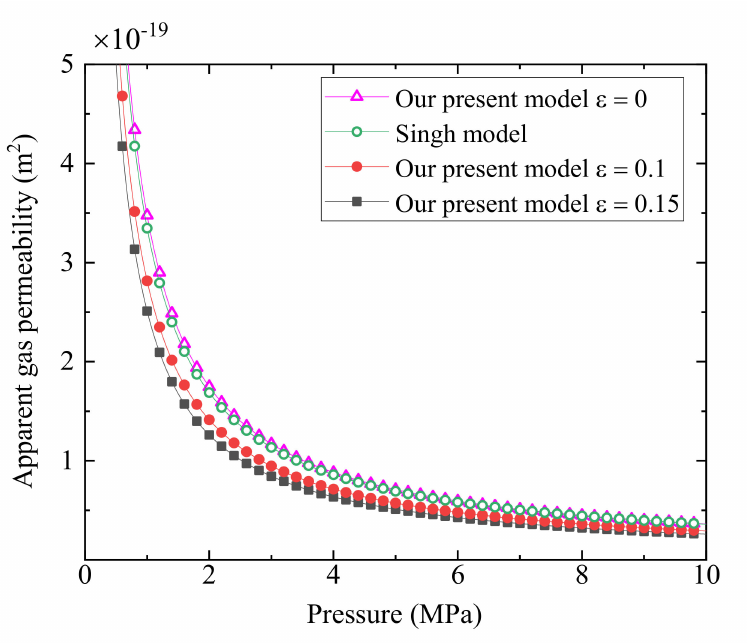
Figure 3. A comparison of apparent gas permeability between the present model Equation (25) and the available model